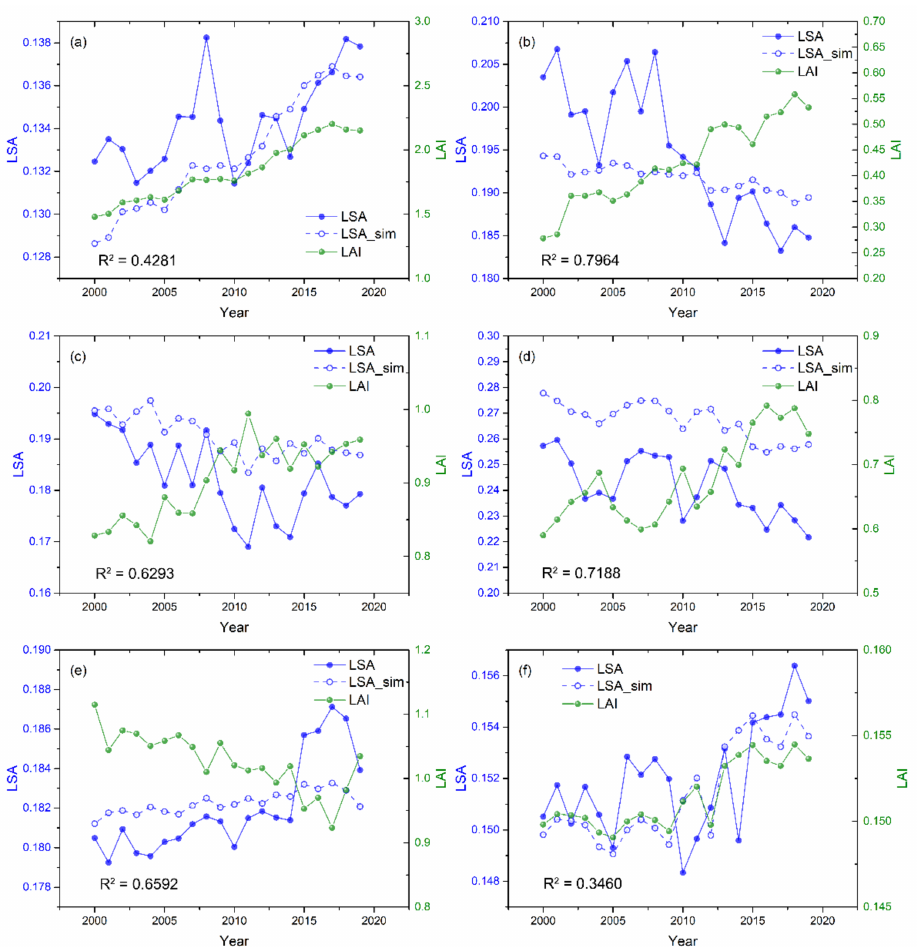
Figure 10. Simulations of regional responses of LSA to LAI changes. ( a ) Southeastern China; ( b ) Loess Plateau; ( c ) Siberia; ( d ) Alaska and northwestern Canada; ( e ) southern edge of the Sahel Desert; and ( f ) southern Brazil. The coefficients of determination for the vegetation-induced LSA model at different regions are also